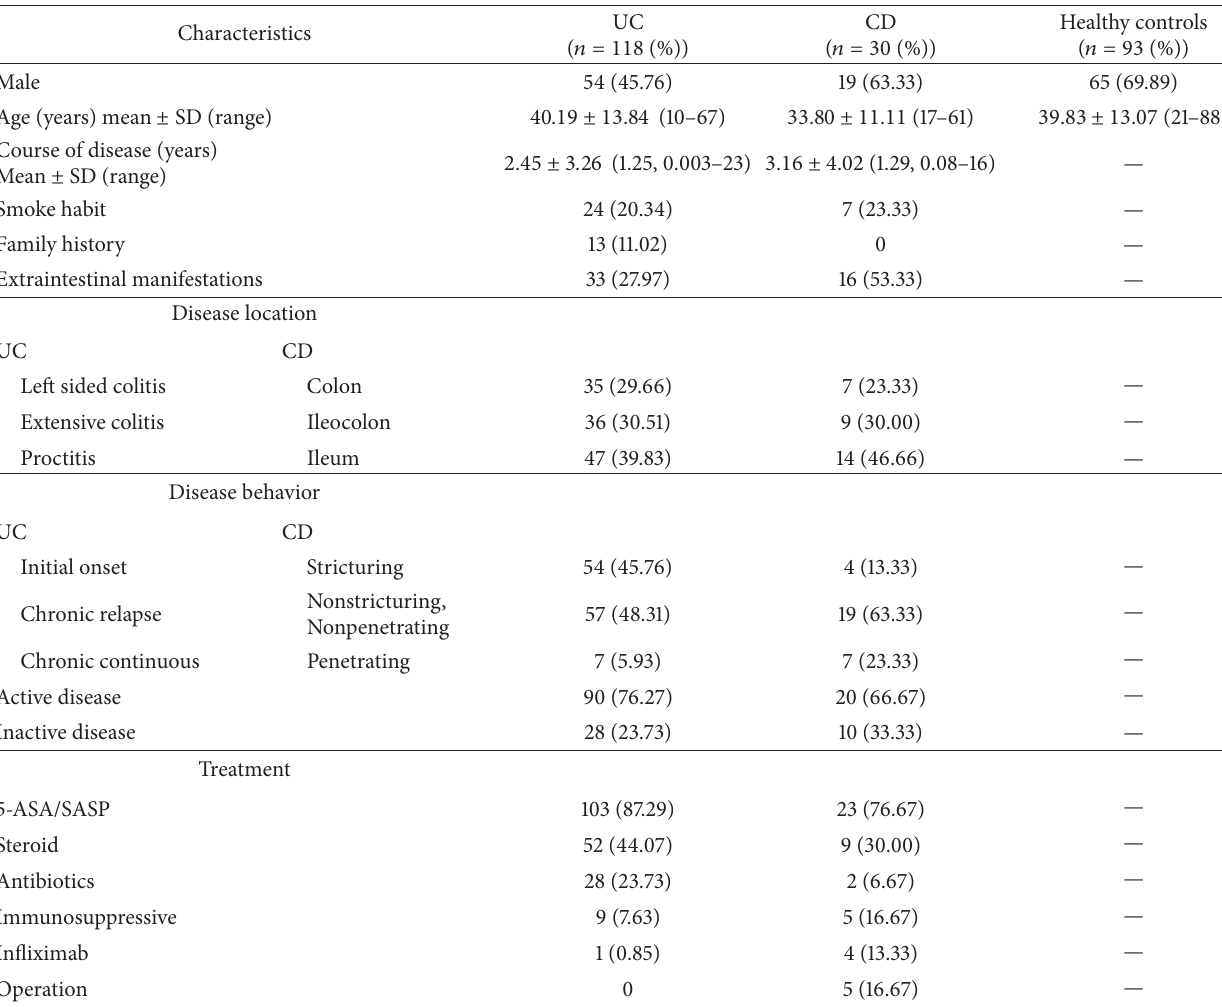
Table 1: Demographic characteristics and clinical features of the patients with UC, CD, and healthy controls.